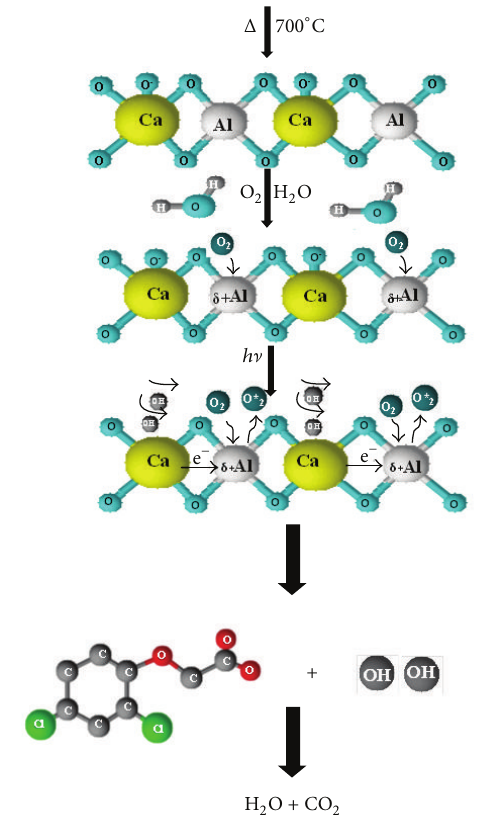
Figure 11: Proposed reaction mechanism.